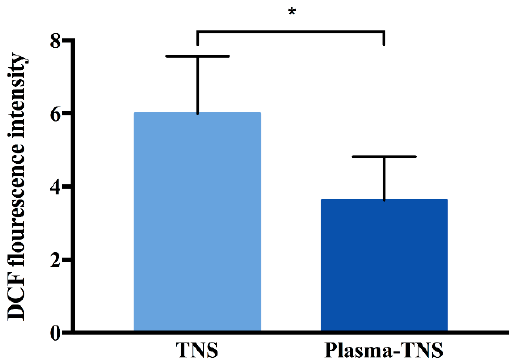
Figure 4. Determination of intracellular reactive oxygen species of rat bone marrow mesenchymal stem cells attached to the TNS and plasma-TNS disks. Data shown are the means ± SD ( n = 3). * p < 0.05.